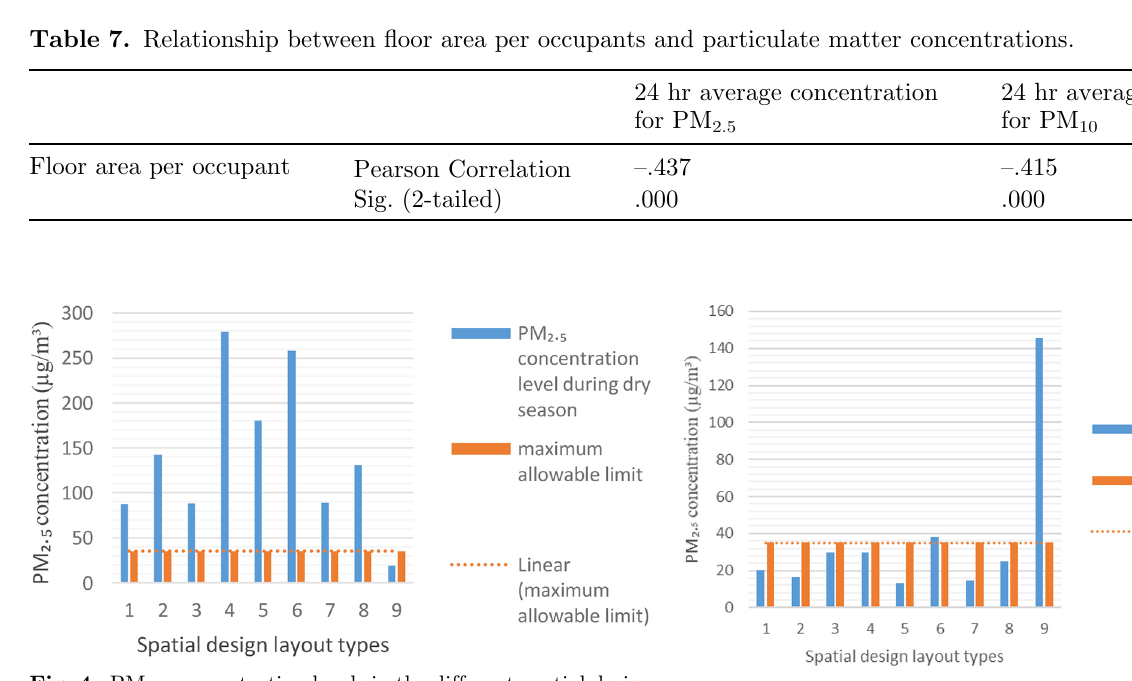
Fig. 6. PM 2.5 concentration levels in the different spatial design layouts during wet